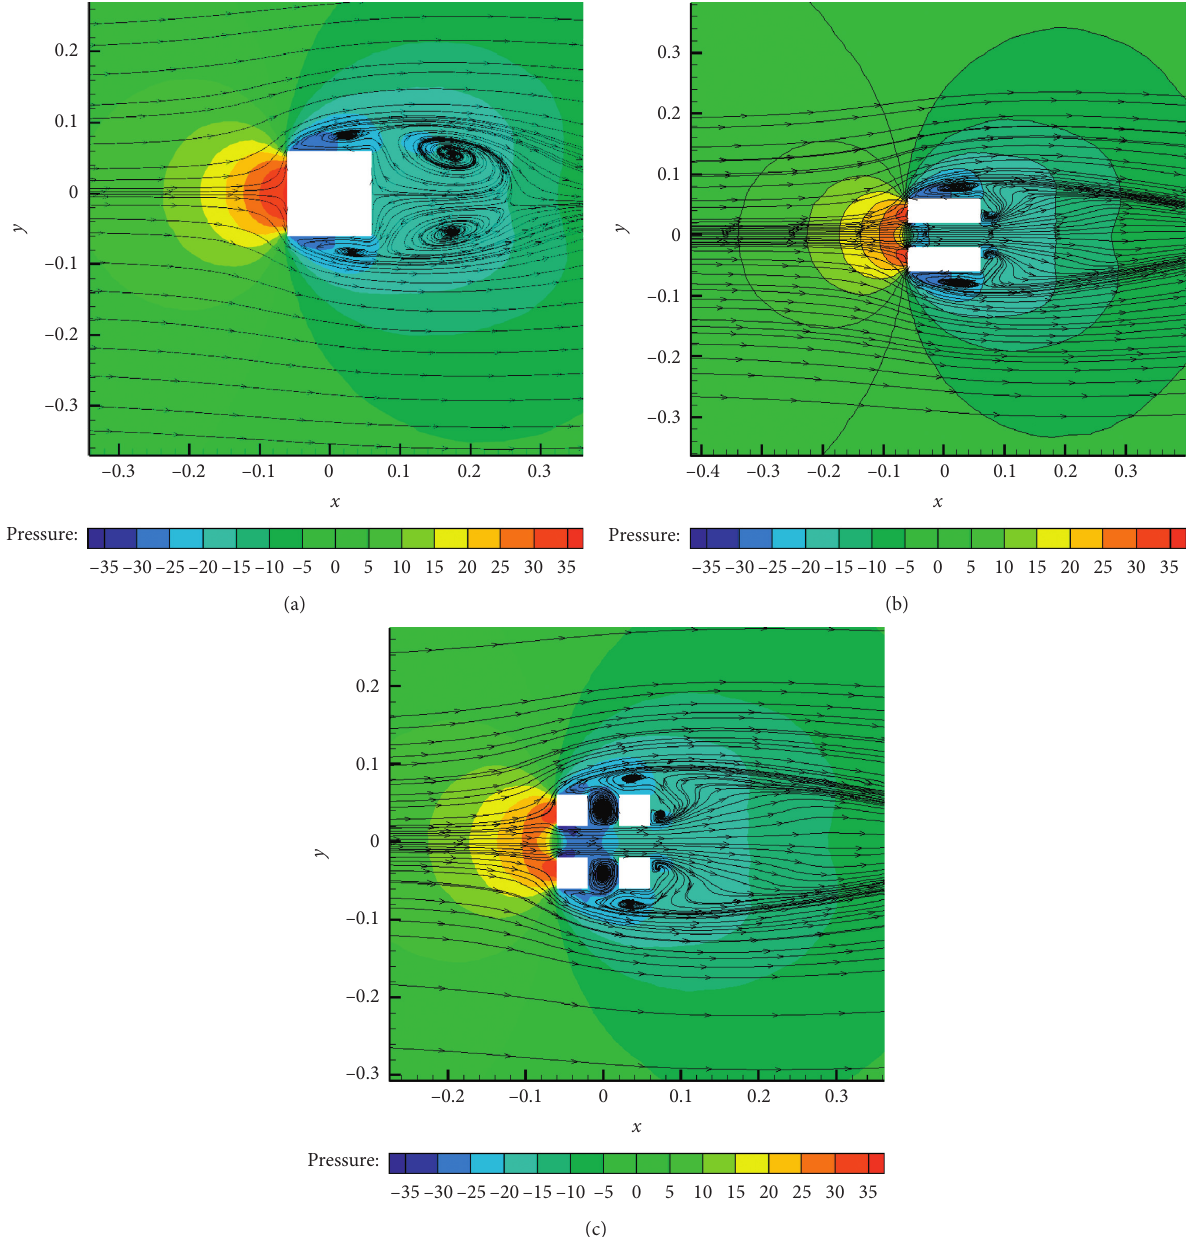
Figure 7: Mean wind pressure contour distributions with streamlines at height of 0.85H. (a) L-1 model. (b) L-2 model. (c) L-3